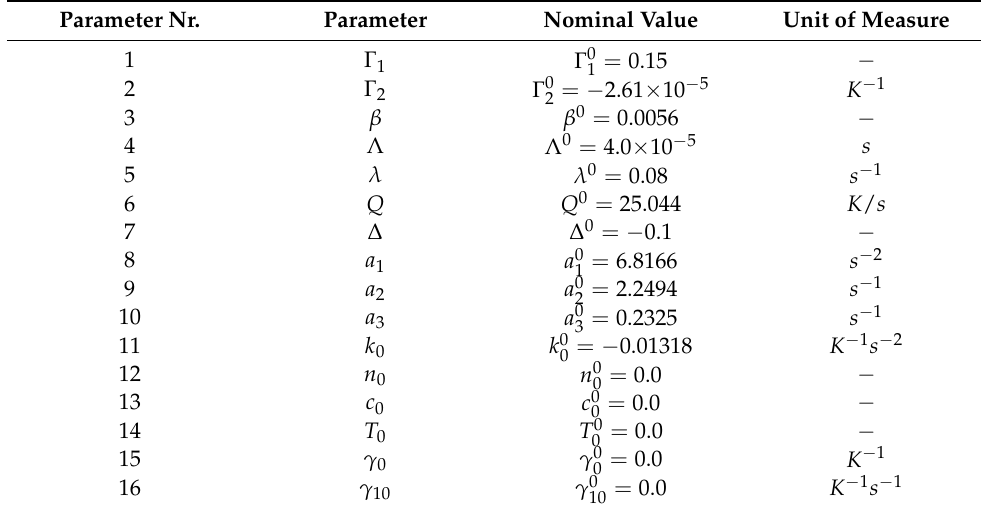
Table 6. Nominal values of imprecisely known BWR model parameters. Parameter Nr. Parameter Nominal